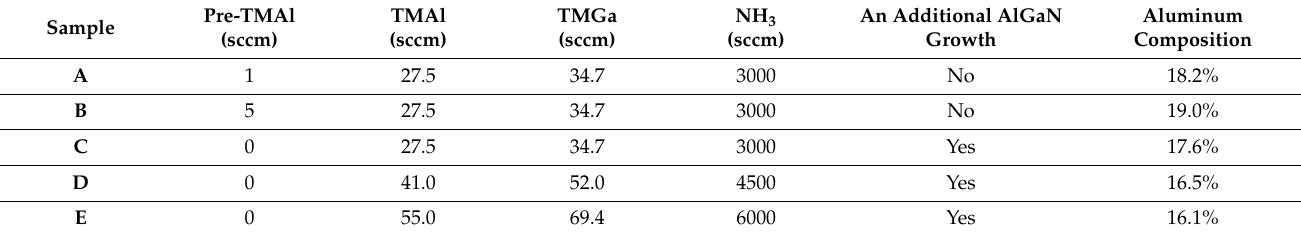
Figure 1. The schematic diagram of the sample structure in the vertical direction. Table 1. The growth parameters of AlGaN samples A, B, C, D, and E.